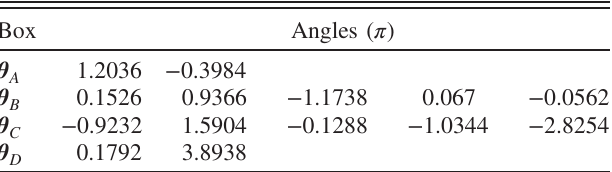
TABLE II. Rotation angles for the individual boxes of the circuit shown in Fig. 1(a) for the four-qubit test-bed system; all angles are given in units of π .